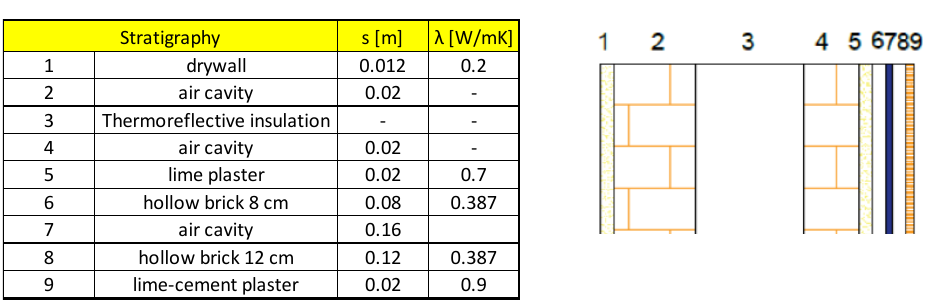
Figure A8. Wall type 3.2: transmittance check for the three main Italian climatic zones. In are blue the heat-reflective materials which respect all the limits.